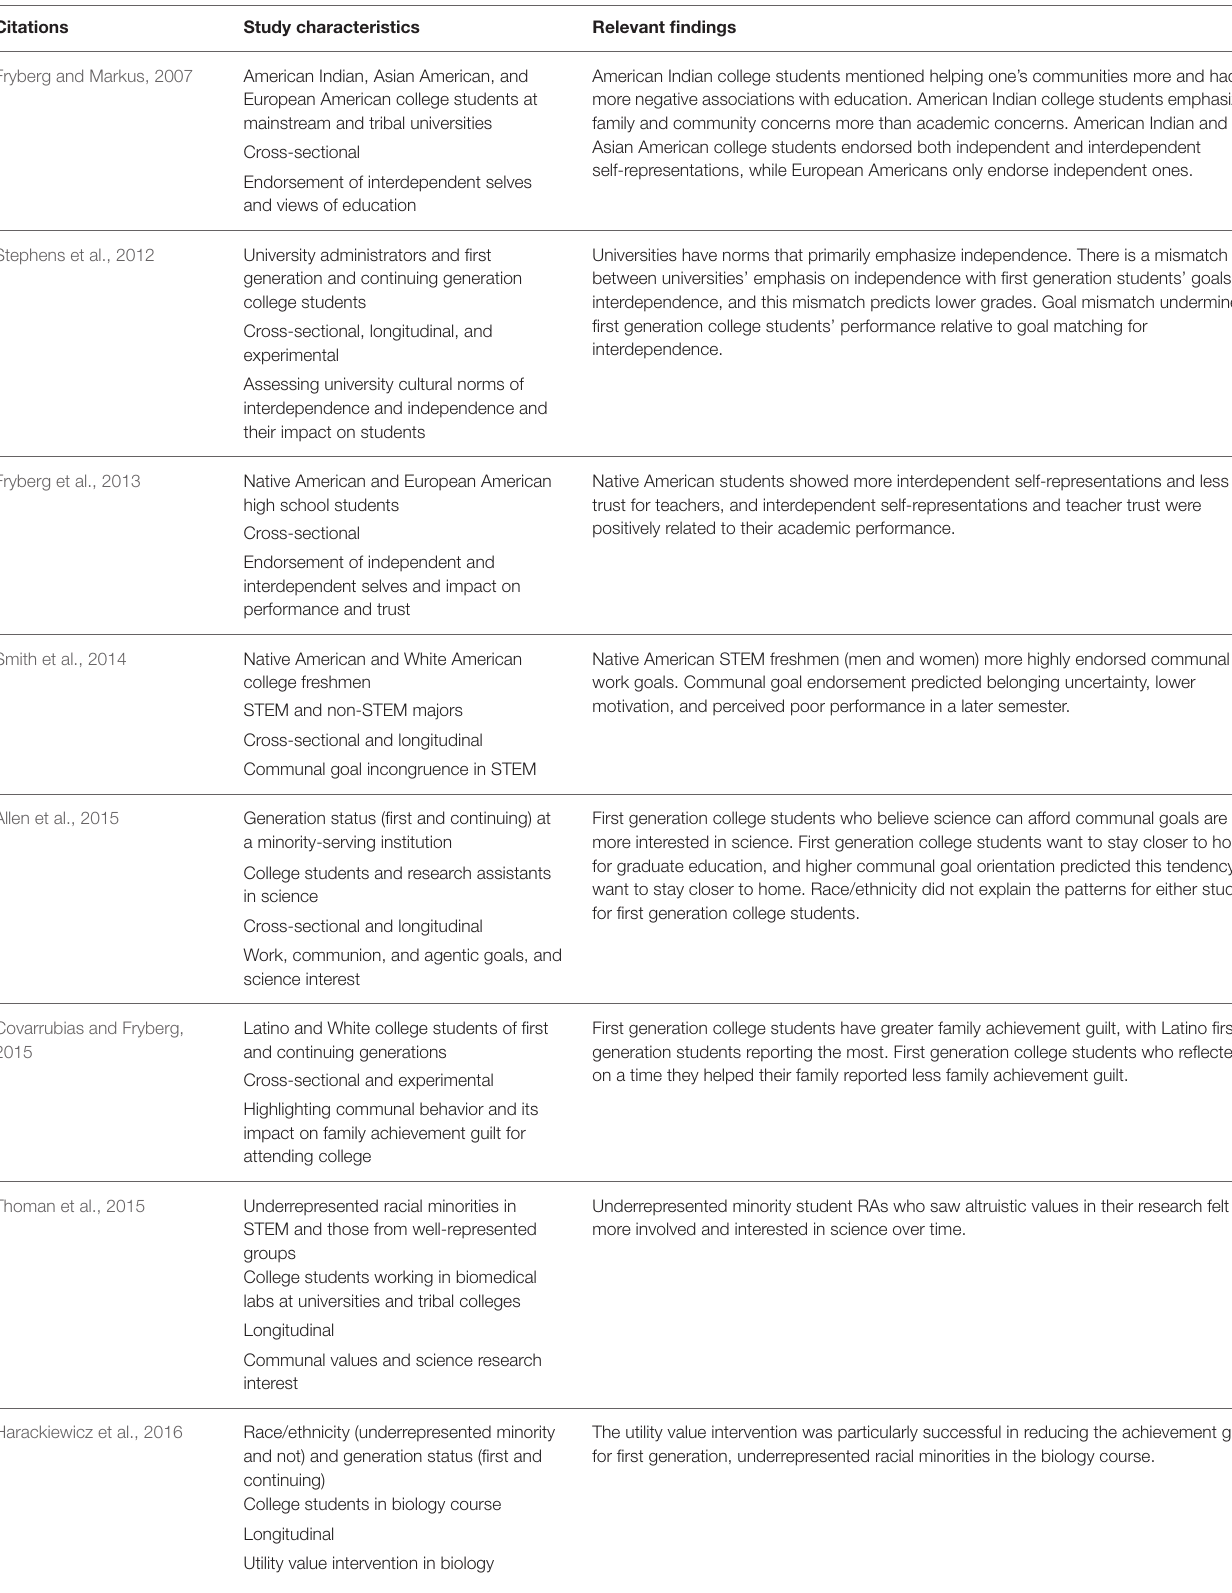
TABLE 2 | Included studies in the focused review with a focus on race/ethnicity and first generation status.